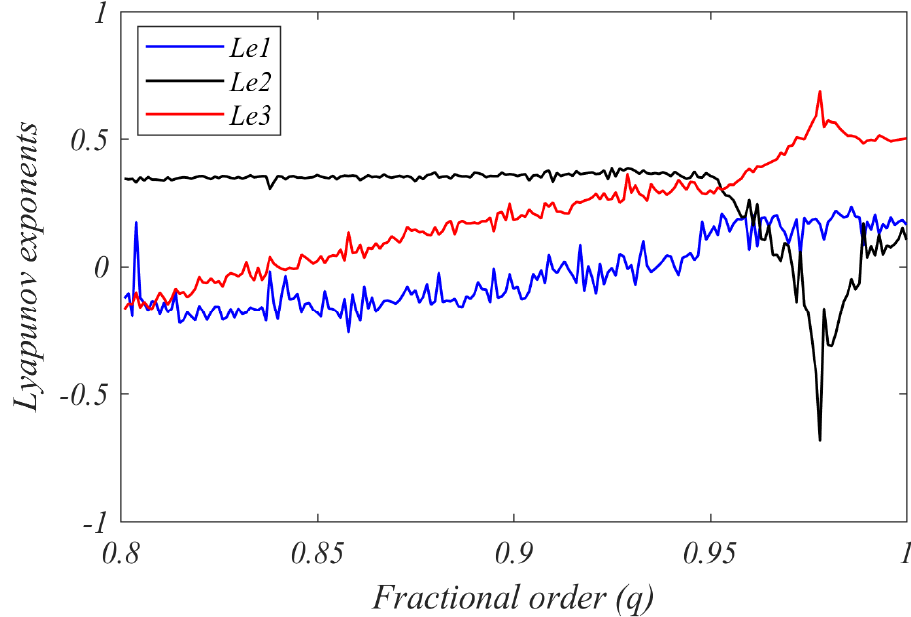
Figure 12. The system (14) Lyapunov exponents against changing the system fractional order ( q ).